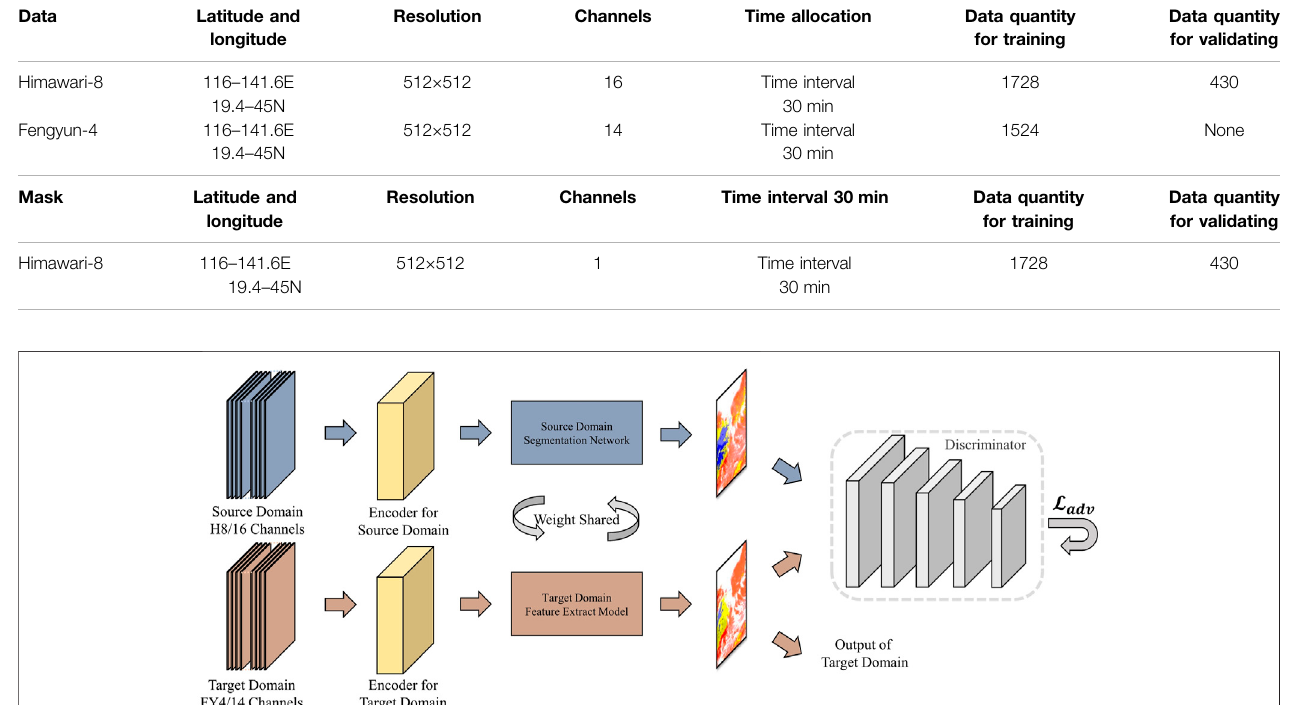
FIGURE 2 | Architecture of network